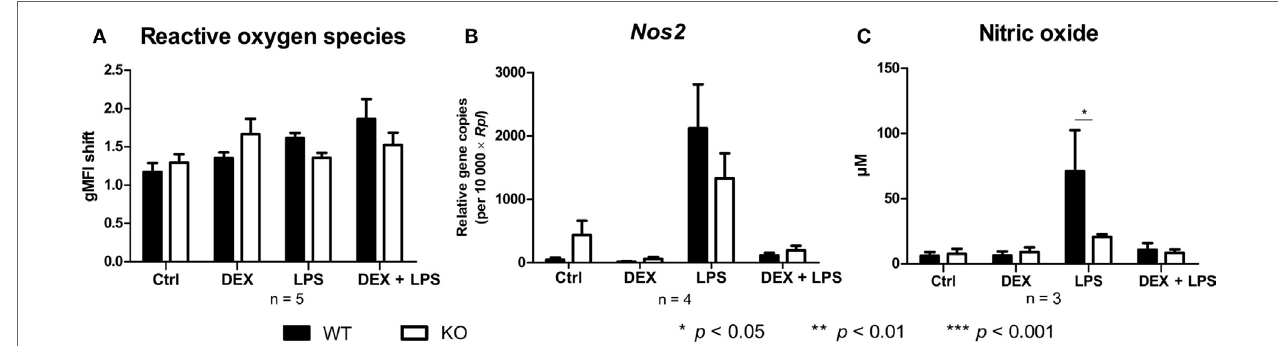
FigUre 4 | Peroxisome proliferator-activated receptor- γ deficiency influences nitric oxide (NO) but not reactive oxygen species production. (a–c) ER-Hoxb8 cells d5 were treated with dexamethasone (DEX) (100 nM) and/or LPS (1 µg/ml) for 48 h. (a) Untreated, DEX- and/or LPS-treated cells were stimulated with 10 nmol/l PMA for 15 min and oxidative burst was measured using DHR. The fluorescence of the cells was determined in FACS. (B) The cells were analyzed for the expression of Nos2 using qPCR. (c) The production of NO was investigated by the NO assay. (a–c) The bars represent the mean with the SEM of three to five independent experiments (* p < 0.05, ** p < 0.01, *** p < 0.001) (calculated by using two-way